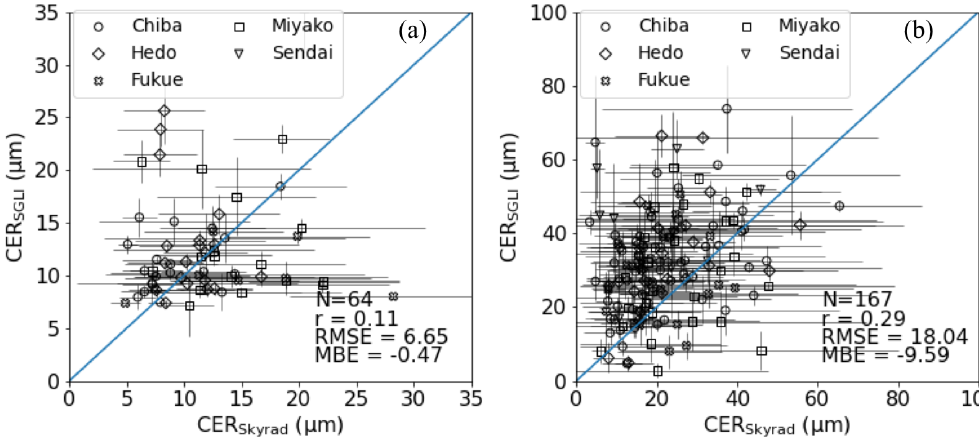
Figure 2. As Fig. 1 but for CER.